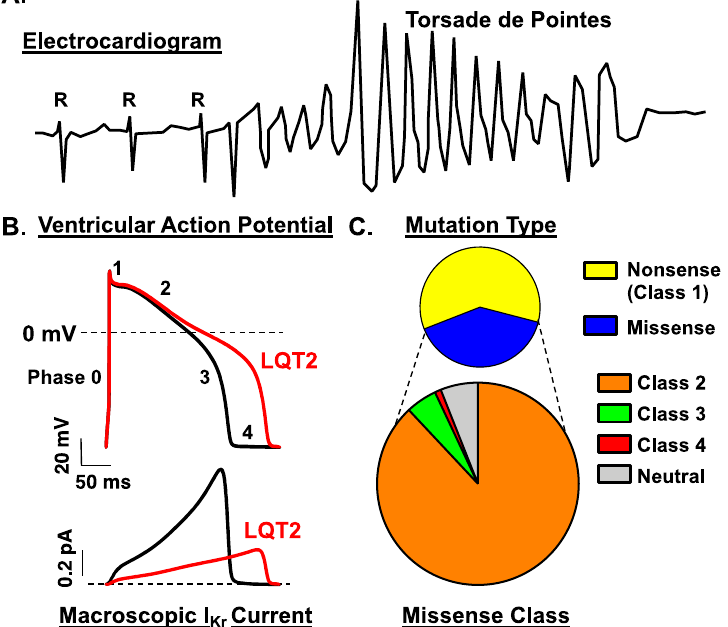
candidate LQT2 mutations that are nonsense (Class 1) or missense. To generate this graph, we defined candidate LQT2 missense mutations as ones that are reported to be “likely pathogenic” or “pathogenic” in ClinVar (https: // www.ncbi.nlm.nih.gov / clinvar). The bottom pie chart shows the relative percentage